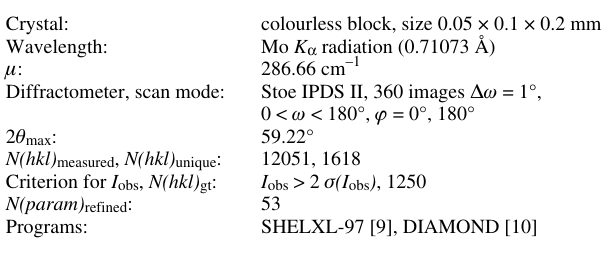
Table 1. Data collection and handling.